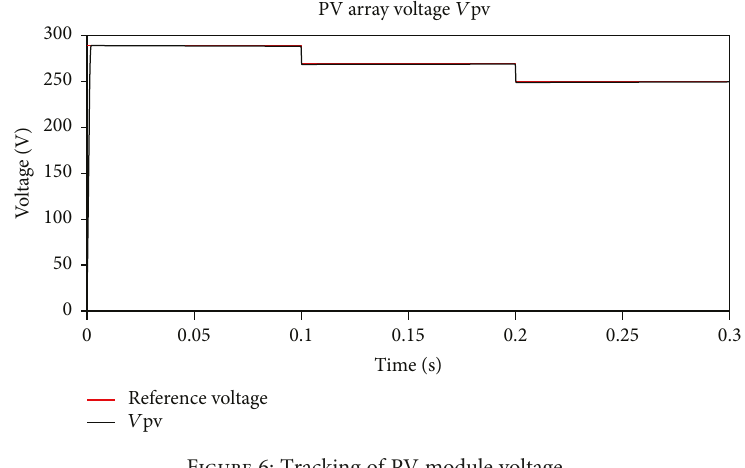
Figure 6: Tracking of PV module voltage.